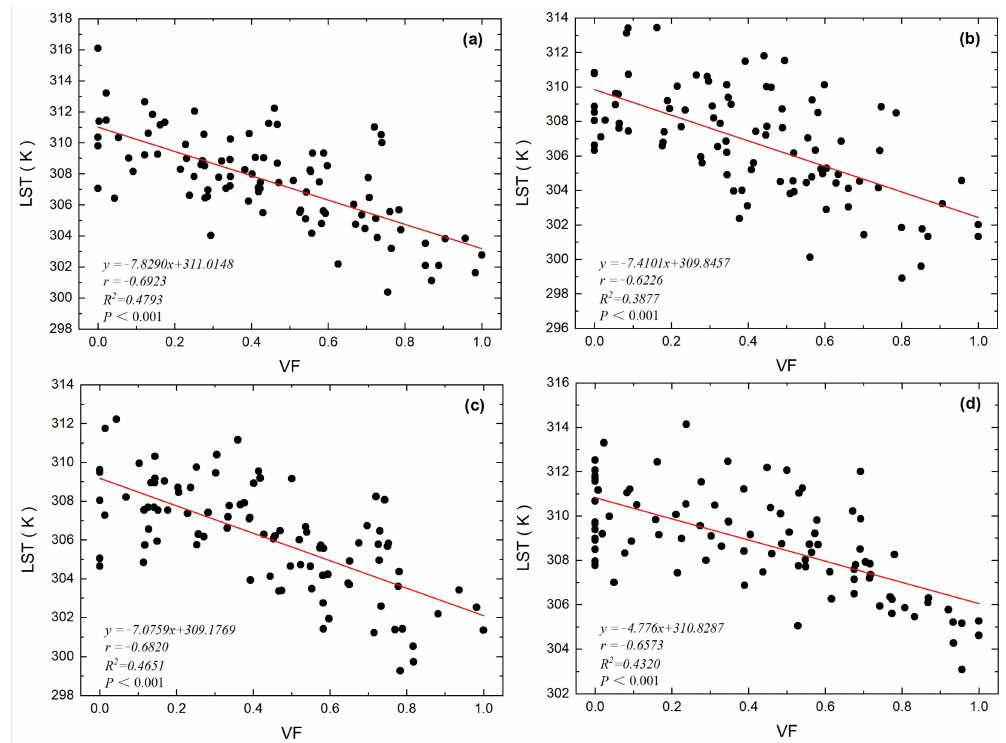
Figure A3. Linear regression between vegetation fraction and land surface temperature of sample points: ( a ) 1 May 2014; ( b ) 16 May 2017; ( c ) 3 May 2018; and ( d ) 17 May